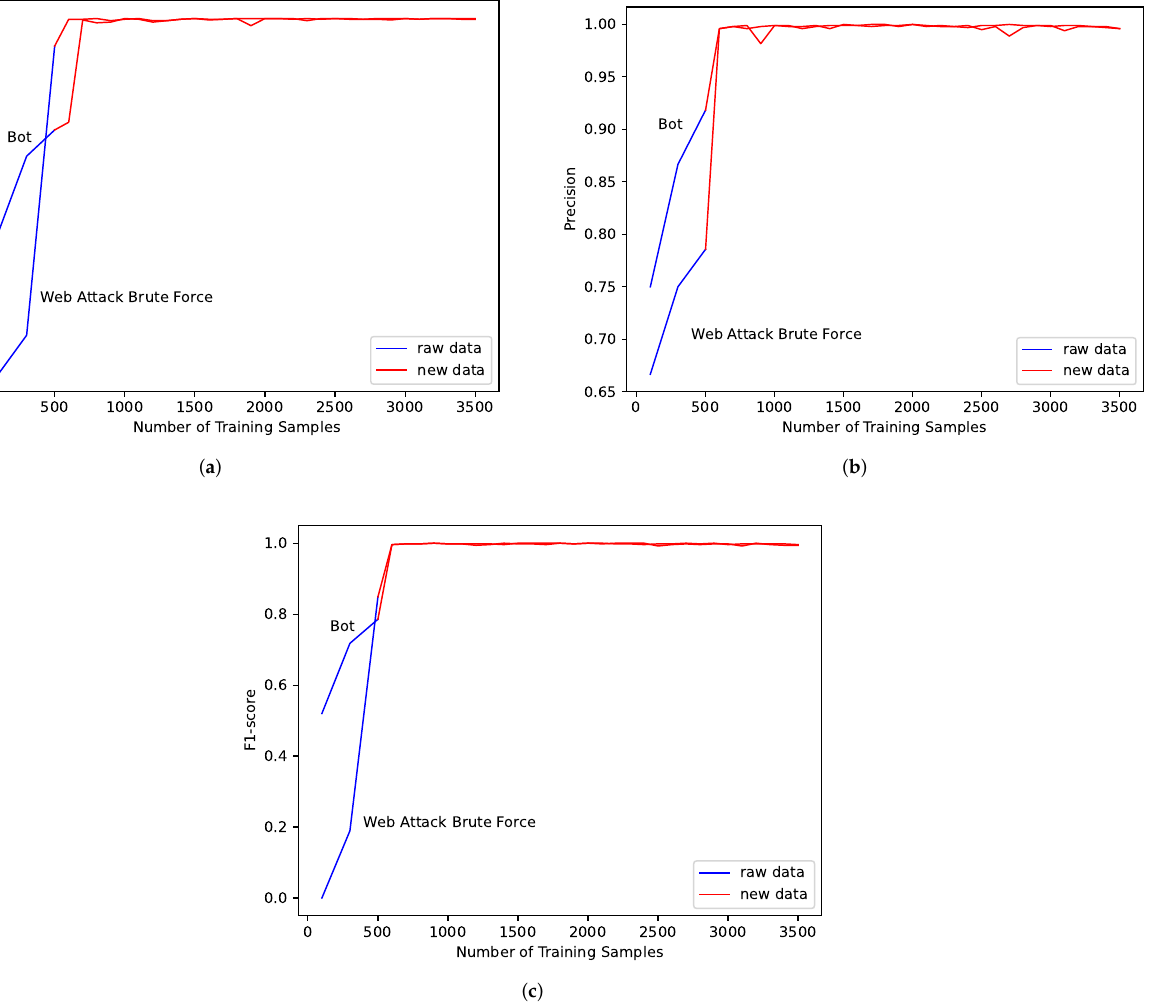
Figure 5. Experimental results of Bot and Web Attack Brute Force in MLP identification algorithm. ( a ) Recall; ( b ) Precision; ( c ) F1-score. Blue curves in the figures represent the original data, and red curves represent syn- thetic data. Considering the needs of practical application, in the experiments of synthetic data, 500 pieces of real traffic data are randomly selected as the test set, and another 500 real traffic data are randomly selected and are mixed with synthetic data as the training set. The control variable method is used in the experiment; that is, when changing the quantity of Bot traffic data, the other categories of data are kept unchanged, and we record the indicators of Bot data. The same operation is performed on Web Attack Brute Force data. It can be seen from the experimental results that the indicators of Bot and Web Attack Brute Force have improved after expansion and finally reach